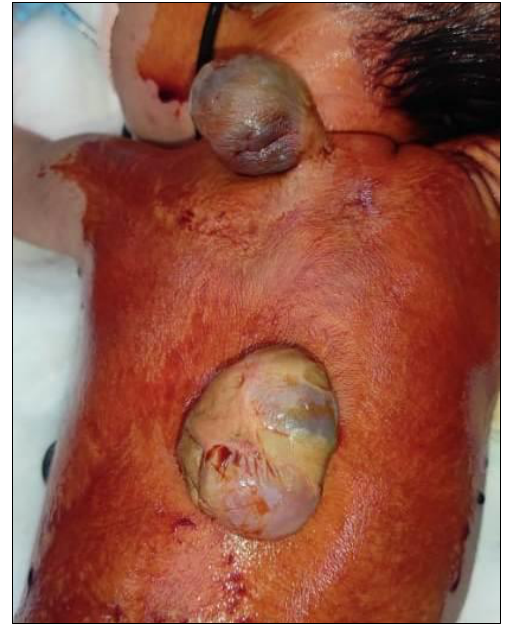
Figure 1: Double MMC at cervical and thoracic region.